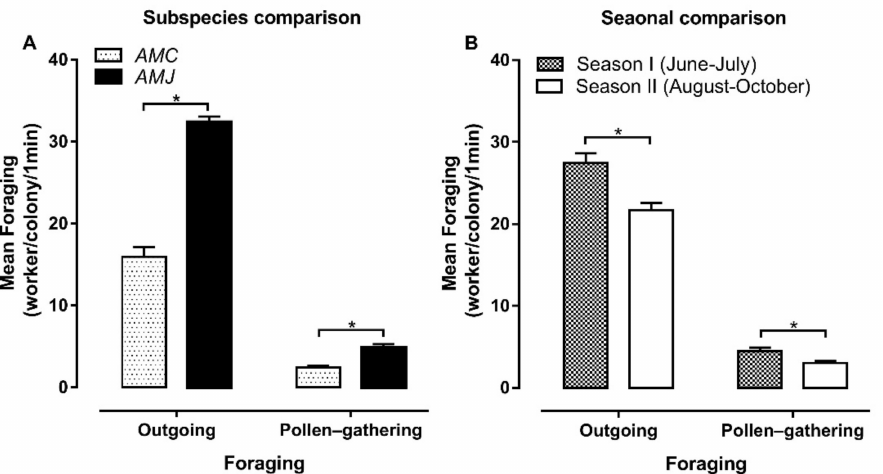
Figure 6. Comparison between the foraging activities (cumulative means for the two combined flowering seasons) of the two studied honey bee subspecies ( AMJ and AMC ) and the cumulative foraging activities of the subspecies combined during the two flowering seasons of Z. nummularia . ( A ) Foraging activities (mean ± SEM) of AMJ and AMC , regardless of season. ( B ) Seasonal compari- son of foraging activities (mean ± SEM) during the two flowering seasons (season I and season II) of Z. nummularia regardless of subspecies. SEM: standard error of the mean. Flowering season I lasted from June–July, and flowering season II lasted from August–October. The asterisks indicate significant differences between the two columns in each graph at p < 0.05.